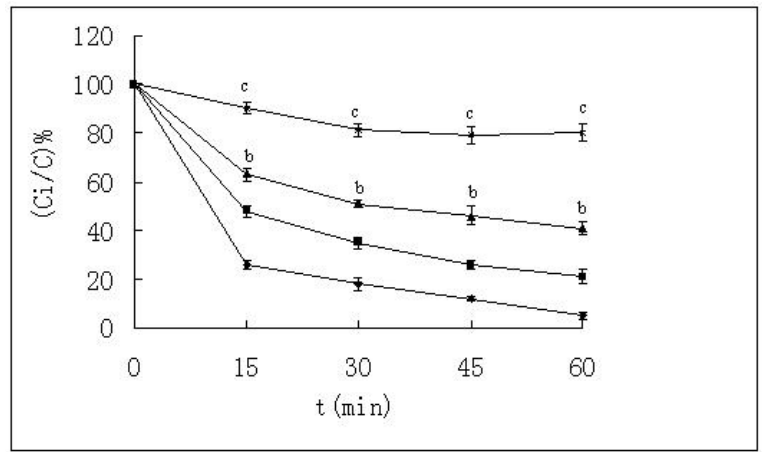
Figure 1. Percentage of the remained insulin against α -chymotrypsin at 37 ºC. ◆ - ◆ Insulin + α -chymotrypsin; ■ — ■ Insulin + HP- β -CD + α -chymotrypsin; ▲ - ▲ Insulin + Casein + α -chymotrypsin; Χ — Χ Insulin + Casein + HP- β -CD + α -chymotrypsin, n=3, mean ± SD. b p < 0.01, c p < 0.001 vs insulin + α -chymotrypsin solution according to paired t-test.